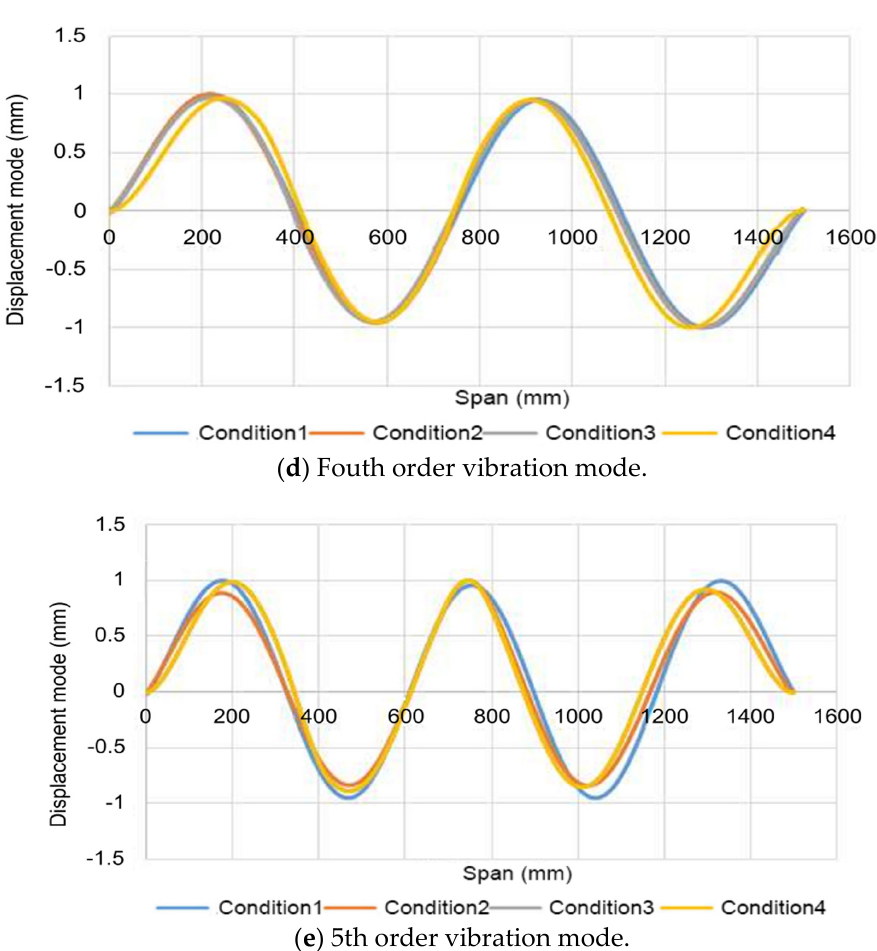
Figure 23. Comparison of mode curves at different orders under Conditions 1 to 4.